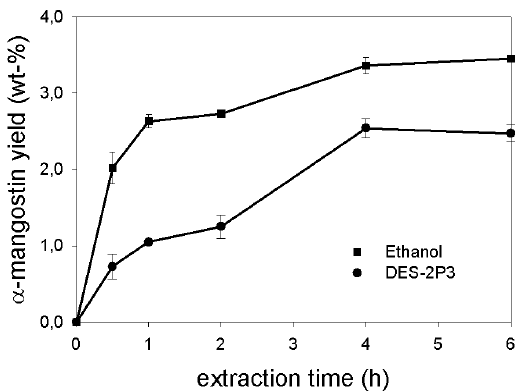
Figure 1. Plots of α -mangostin yield as a function of extraction time. Data obtained using choline chloride-1,2-propanediol deep eutectic solvent (DES) (mole ratio of 1:3) and ethanol as extracting solvents.